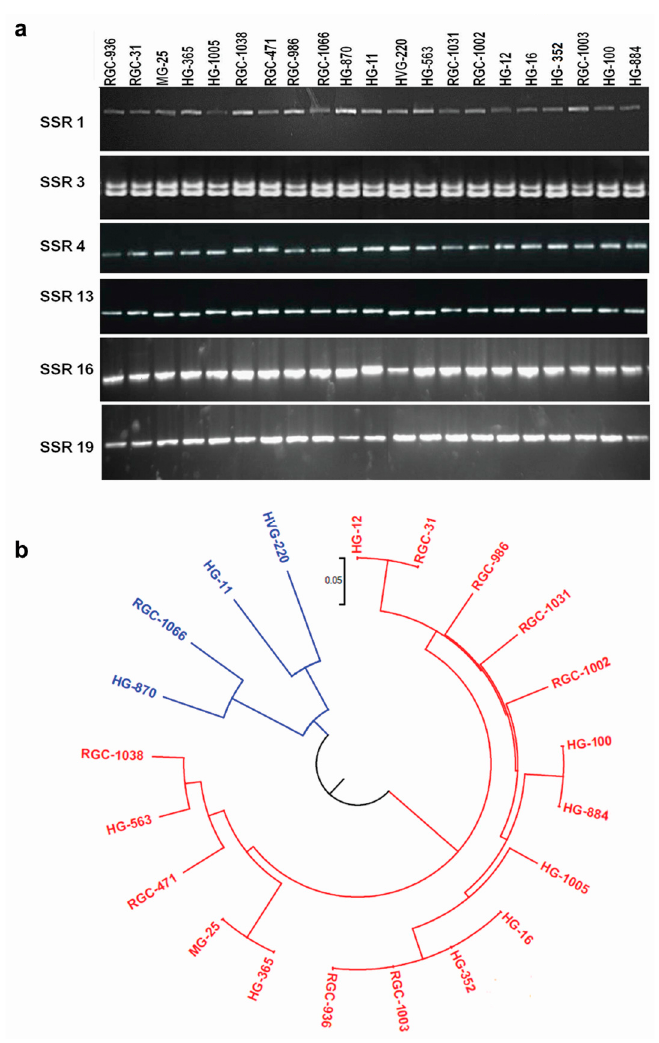
Figure 5. Validation of randomly selected simple sequence repeats from HQ unigenes. ( a ) Banding pattern of SSR primers’ amplification on genomic DNA of 21 varieties of C. tetragonoloba ; ( b ) genetic relationship among the 21 clusterbean accessions as revealed by the UPGMA method in the Numerical Taxonomy System (NTSYS-pc) ver. 2.1